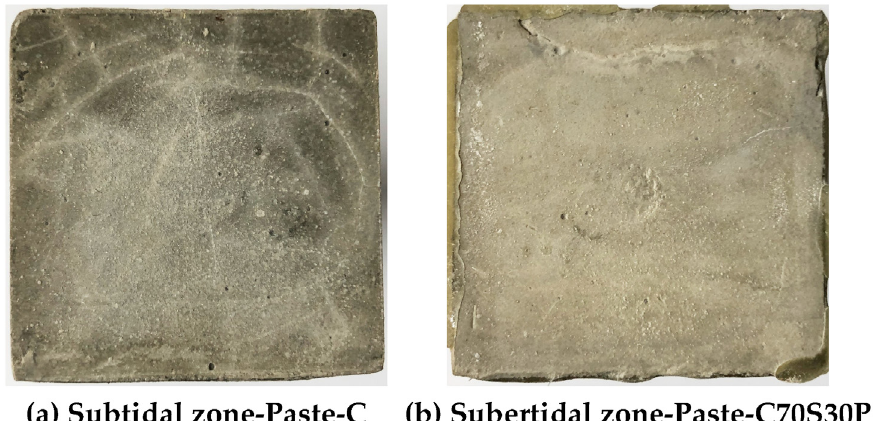
Figure 18. The synergistic influence of slag powder and polypropylene fibers on the macroscopic morphology of the exposed surface after 180 days of complete immersion-coupled chloride ion erosion.